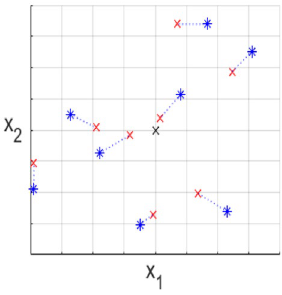
Fig. 3 Scheme of the FOSS method based on a LHS for n − 1 points, whereby the asterisks belong to the LHS method and the crosses to the FOSS method. The cross in the center is the additional core value in contrast to the LHS